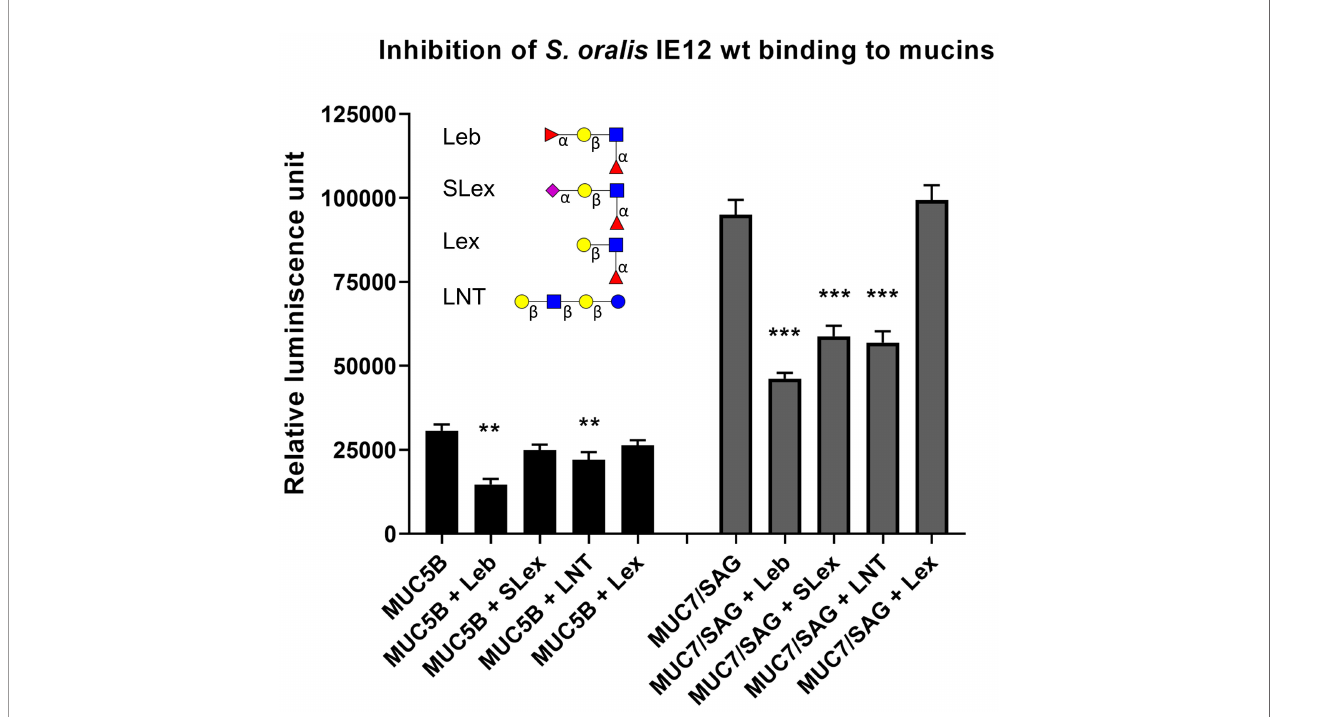
FIGURE 4 | Inhibition of S. oralis binding to salivary mucins using glycoconjugates. S. oralis IE12 WT was pre-treated with 50 ug/mL of Leb-HSA, SLex-APD- HSA, Lex-APD-HSA or LNT-APD-HSA prior to addition to microtiter plates coated with MUC5B and MUC7/SAG from sample 1. Data shown with background control subtracted. The bars represent mean ± SEM (n=6), ** indicates p ≤ 0.01 and *** p ≤ 0.001, One-way ANOVA, Dunnett´s post hoc test. The results have been reproduced in three independent experiments and a representative experiment is shown here. The structures used for inhibition are depicted using Symbol Nomenclature for Glycans: ( ) = Fuc, ( ) = Gal, ( ) = GlcNAc, ( ) = GalNAc and ( ) =